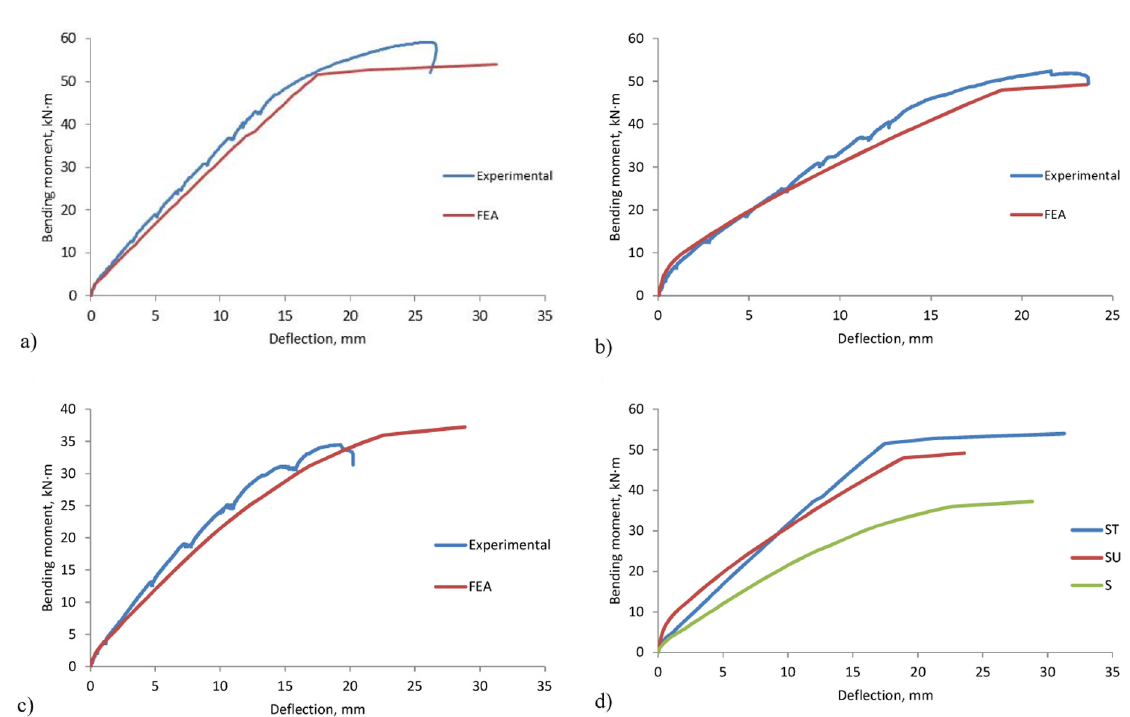
beamsFig. 14. Comparison of experimentally and numerically predicted deflection: (a) SxT beams, (b) SxU beams, (c) Sx beams, (d) comparison of numerically predicted deflections of the SxT, SxU, and Sx